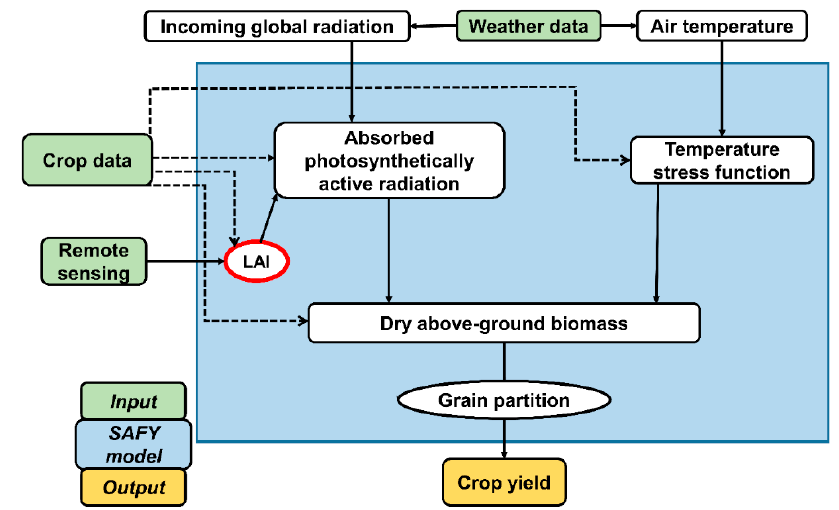
Figure 4. Schematic overview of the physiological processes modeled in SAFY. The assimilation of remote-sensing information to estimate the leaf area index (LAI) is highlighted in red.